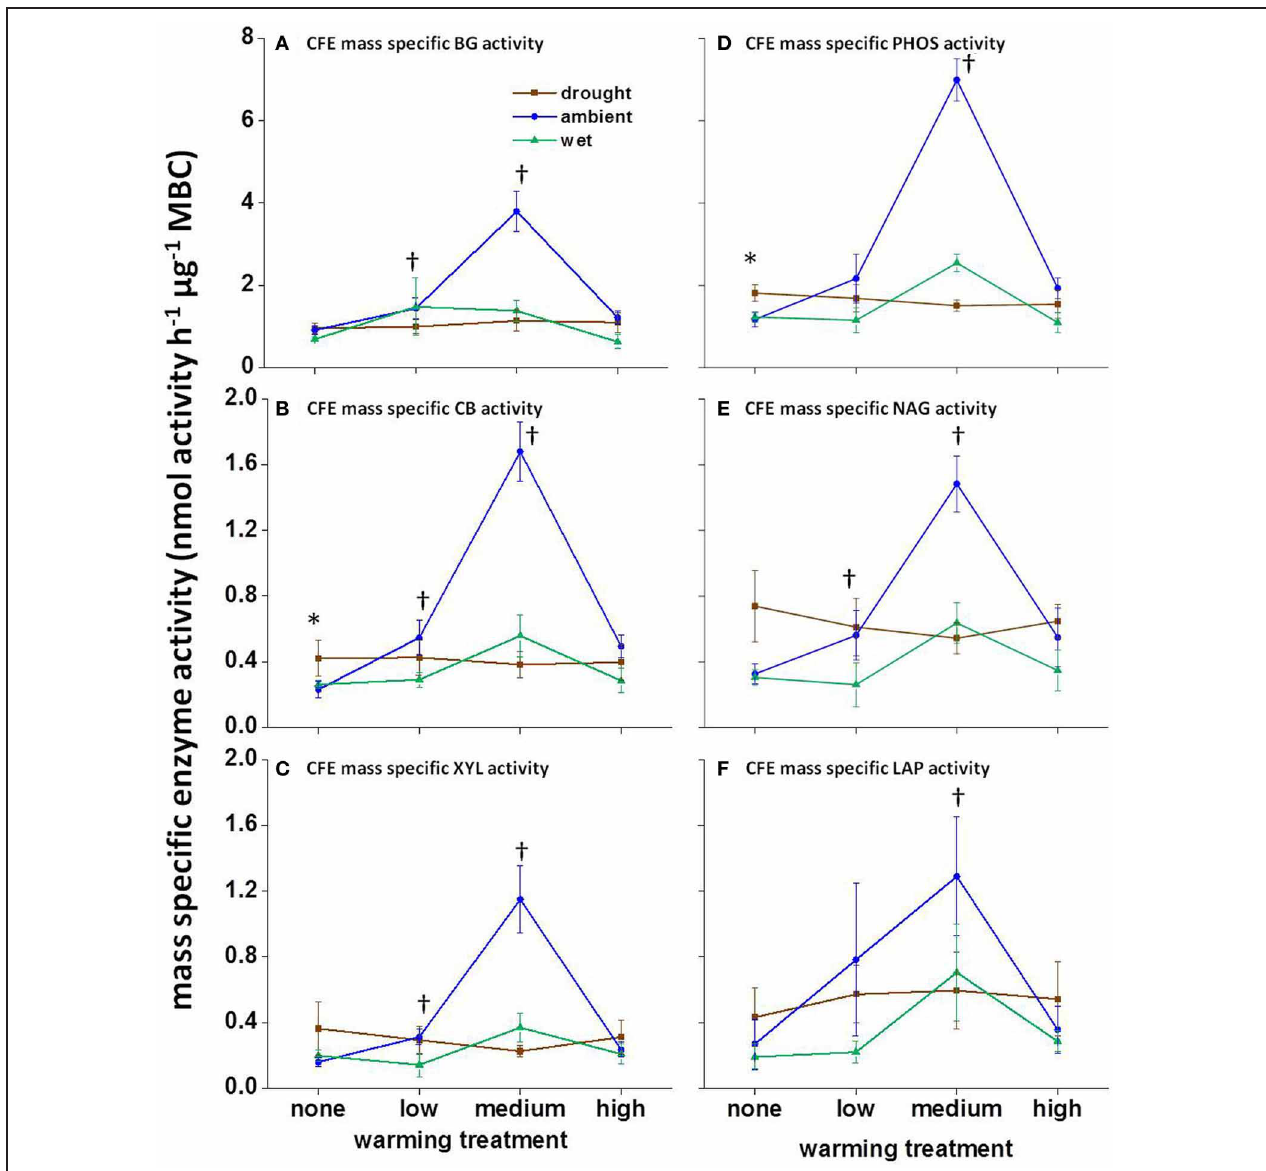
FIGURE 3 | Mass-specific potential enzyme activity in June 2009 calculated using CFE estimated biomass. CFE estimated mass specific enzyme activity for (A) BG, (B) CB, (C) XYL, (D) PHOS, (E) NAG, and (F) LAP. For each substrate, asterisks indicate significant differences in mass-specific enzyme activity ( P < 0 . 05) between the